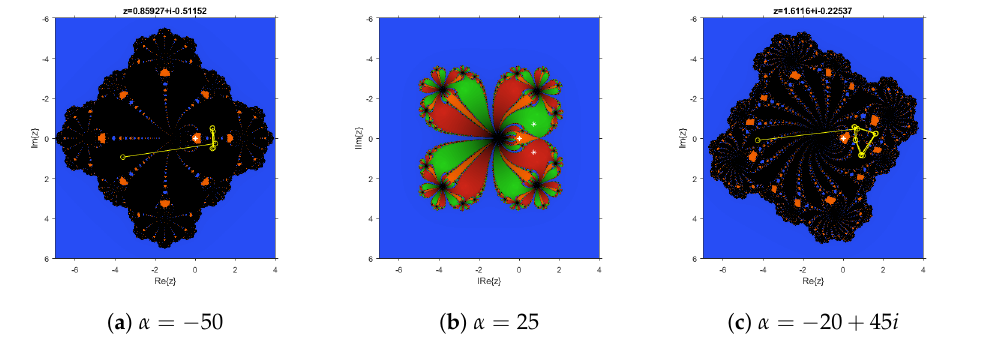
Figure 5. Unstable performance of operator O α ( z )